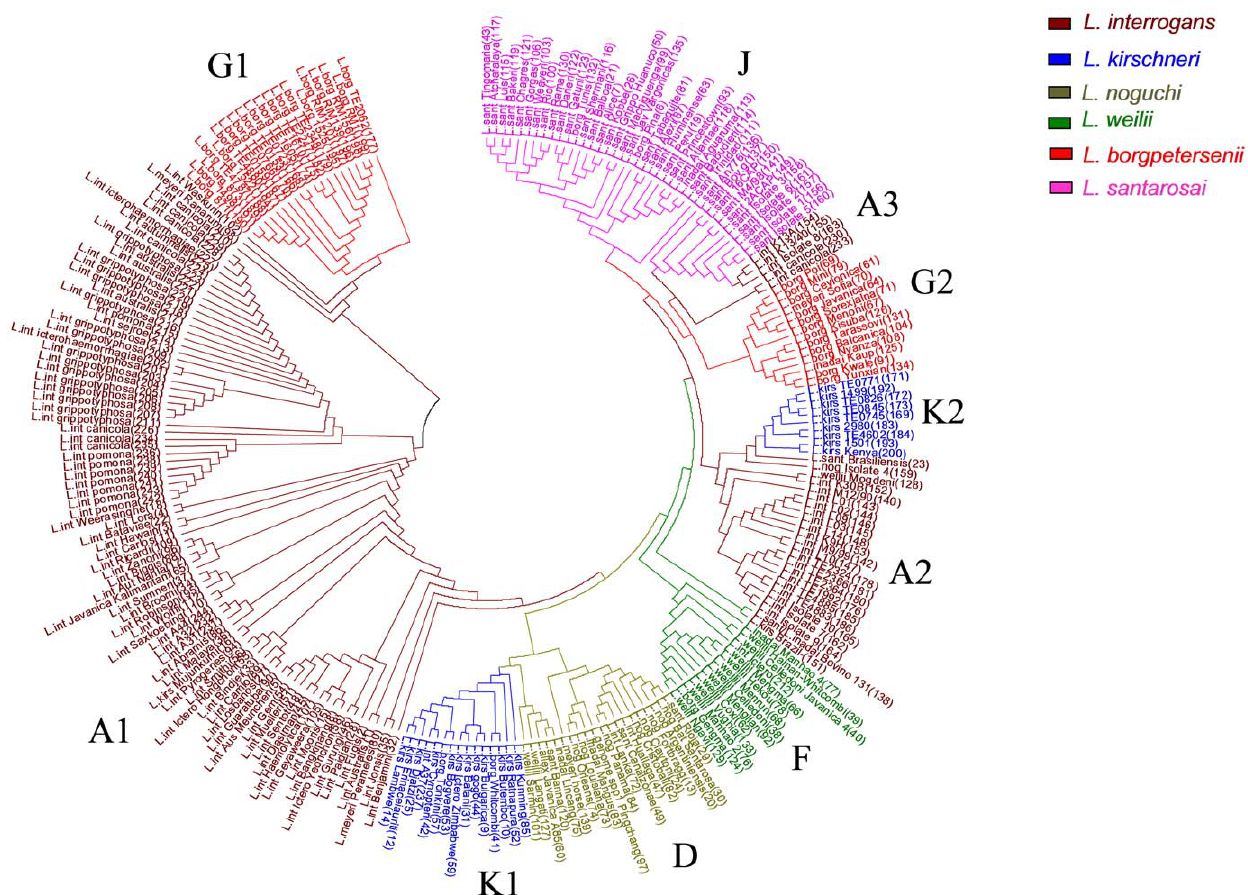
Figure 1. Genetic relatedness among Leptospira isolates based on FAFLP analysis. (See supplementary information, tables S1 and S2 for details.) Clades roughly corresponding to different species types have been marked in different colors. Major clades and minor clades have been identified by code names (A to K) which overlap with the designation of similar clades identified by MLST technique. Identities of individual isolates need not be comprehensible in the tree itself, but they can be read clearly in the supplementary Table S2. The phylogenetic tree was rendered and visualized by MEGA3.0 software.